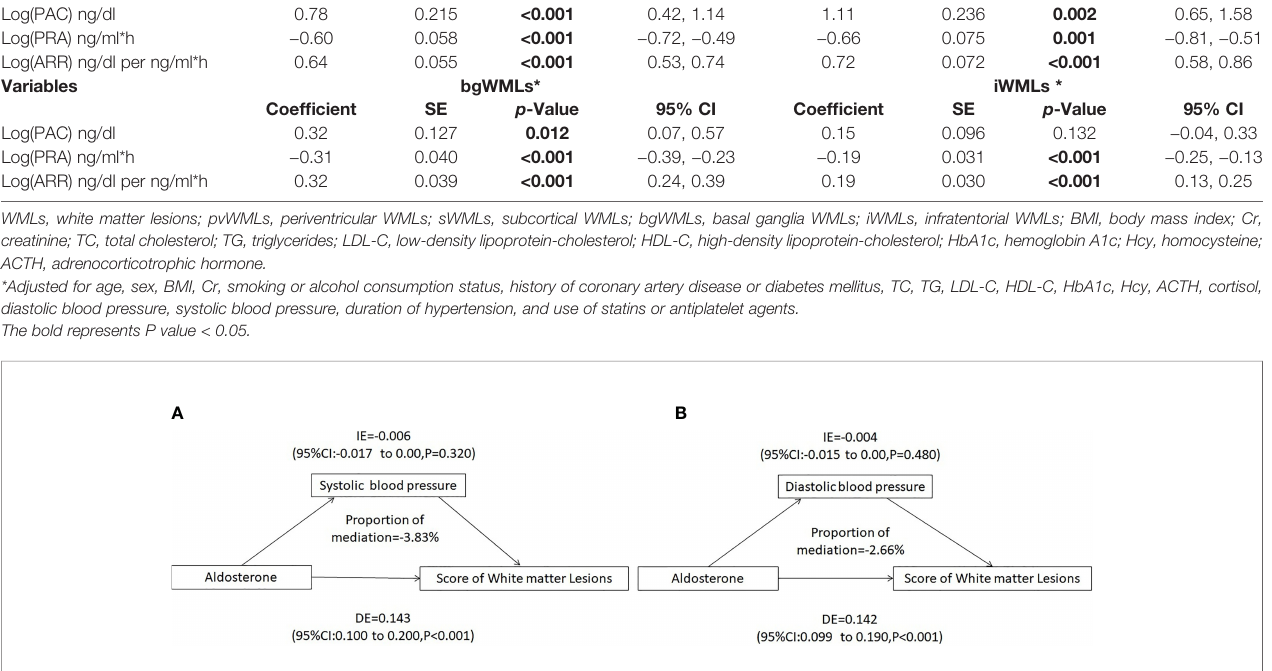
FIGURE 4 | Mediating analysis of systolic or diastolic blood pressure on PAC and white matter lesion Load. (A) Systolic blood pressure mediated a -3.83% association between PAC and white matter lesion load, (B) Diastolic blood pressure mediated a -2.66% association between PAC and white matter lesion load. Adjusted for age, sex, BMI, Cr, smoking or alcohol consumption status, history of coronary artery disease or diabetes mellitus, TC, TG, LDL-C, HDL-C, HbA1c, Hcy, ACTH, cortisol, and use of statins or antiplatelet agents. IE, indirect effect; DE, direct effect; BMI, body mass index; Cr, creatinine; TC, total cholesterol; TG, triglycerides; LDL-C, low-density lipoprotein-cholesterol; HDL-C, high-density lipoprotein-cholesterol; HbA1c, hemoglobin A1c; Hcy, homocysteine; ACTH, adrenocorticotrophic hormone.